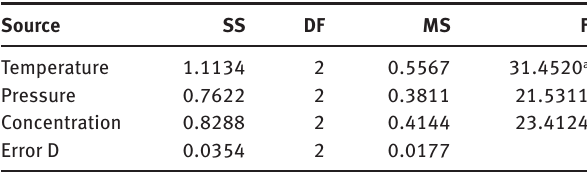
Table 4: The variance analysis for the key performance indexes of the activated